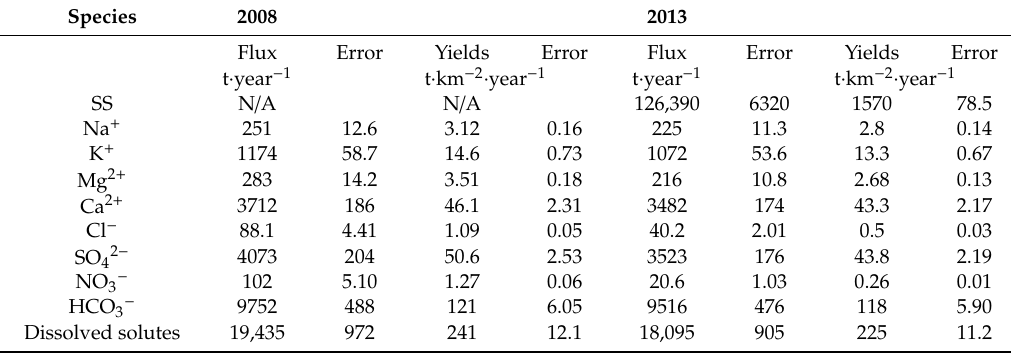
Figure 5. Seasonal variations in the proportions of daily (FLU) and cumulative (CFL) fluxes for major ions and suspended sediments (SS) in river water, in comparison to the proportions of daily (DIS) and cumulative (CDI) discharge at the Hailuogou basin over two melt seasons in 2008 and 2013. Table 4. The flux and yields (with an estimated 5% error due to the bias between modeled and observed discharge) of major ions and suspended sediments (SS) in river water draining Hailuogou Glacier over two melt seasons in 2008 and 2013. N / A denotes data are not